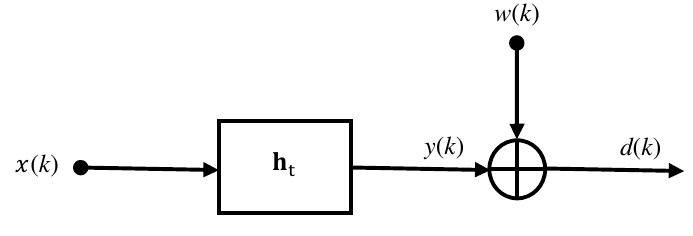
Figure 1. A general block diagram of the LSISO system from